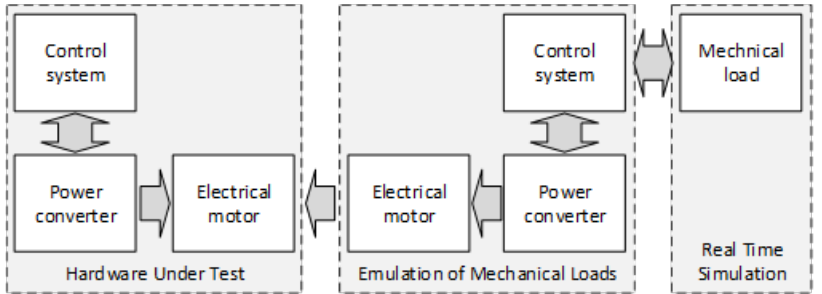
Figure 2. Mechanical-level of Hardware-In-the-Loop (HIL) simulation.